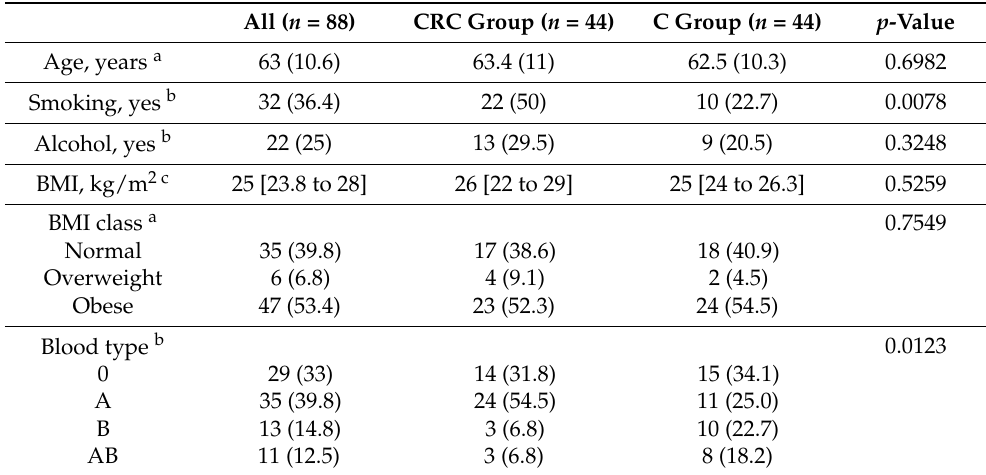
Table 1. Demographic and clinical characteristics by groups. All ( n = 88) CRC Group ( n = 44) C Group ( n =